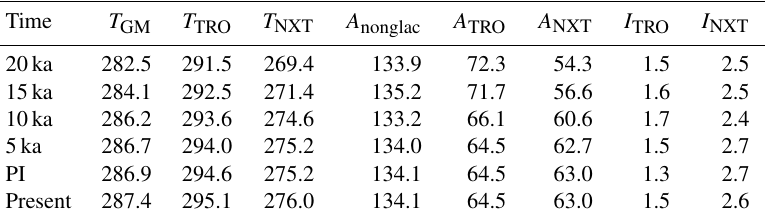
Table 1. Climate and areas given in experiments. Global mean annual temperature T GM , TRO temperature T TRO , and NXT temperature T NXT (all in kelvin). Global nonglaciated land area A nonglac , TRO area A TRO , NXT area A NXT , TRO effective inundated area I TRO , and NXT effective inundated area I NXT (all in 10 6 km 2 ).